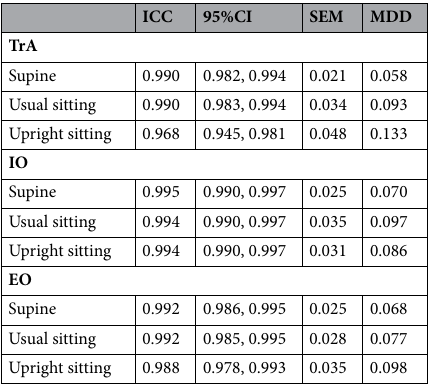
Table 2. Intra-rater reliability of measures of abdominal muscle thickness in three positions. ICC intrarater intraclass coefficient, CI confidence interval, SEM standard error of measurement, MDD minimal detectable difference, TrA transverse abdominis muscle, IO internal oblique muscle, EO external oblique muscle.